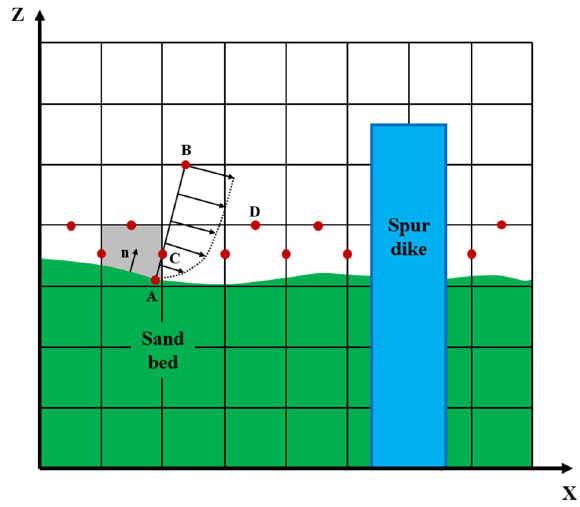
Figure 2. Implement of the wall functions in this model.